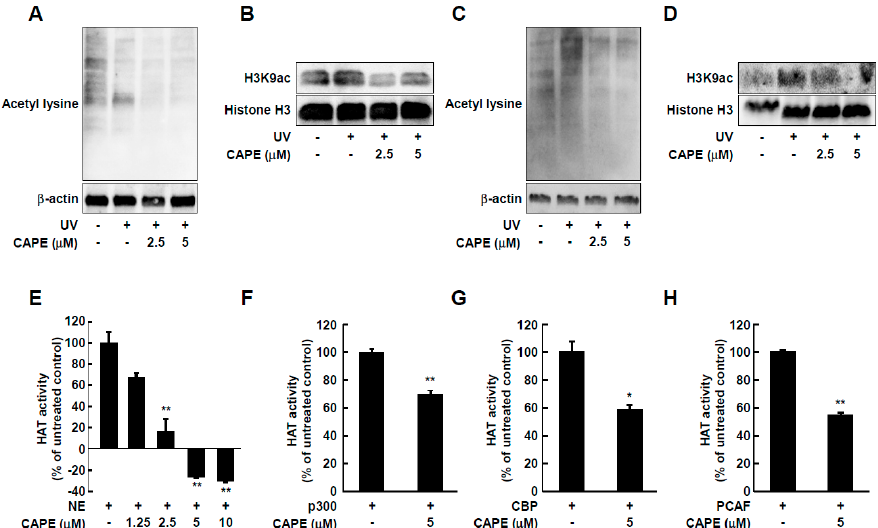
Figure 5. Effect of CAPE on histone acetyl transferase activity and UV-stimulated acetylated lysine and histone H3k9 acetylation in whole cell and tissue lysates. ( A – D ) HDF cells and tissue lysates were examined for the acetylation of lysine (non-histone) and histone H3 lysine 9 by immunoblotting. ( E ) Effect of CAPE on HAT activity was assessed in the presence of CAPE at the indicated concentrations using colorimetric HAT assay kit. ( F – H ) Enzyme-specific HAT activities of CAPE were measured using the purified enzymes p300, CBP, and PCAF. The data are expressed as mean ± SD of three independent experiments. * p < 0.05 and ** p < 0.01 versus untreated control.